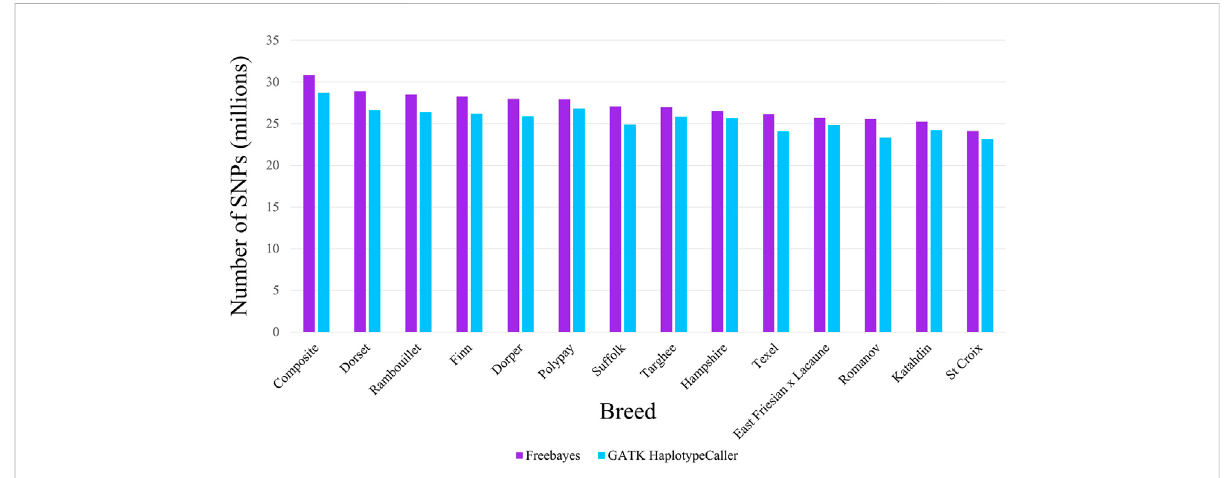
TABLE 2 Pairwise concordance of SNP data between both variant callers and bead array. Breed Freebayes